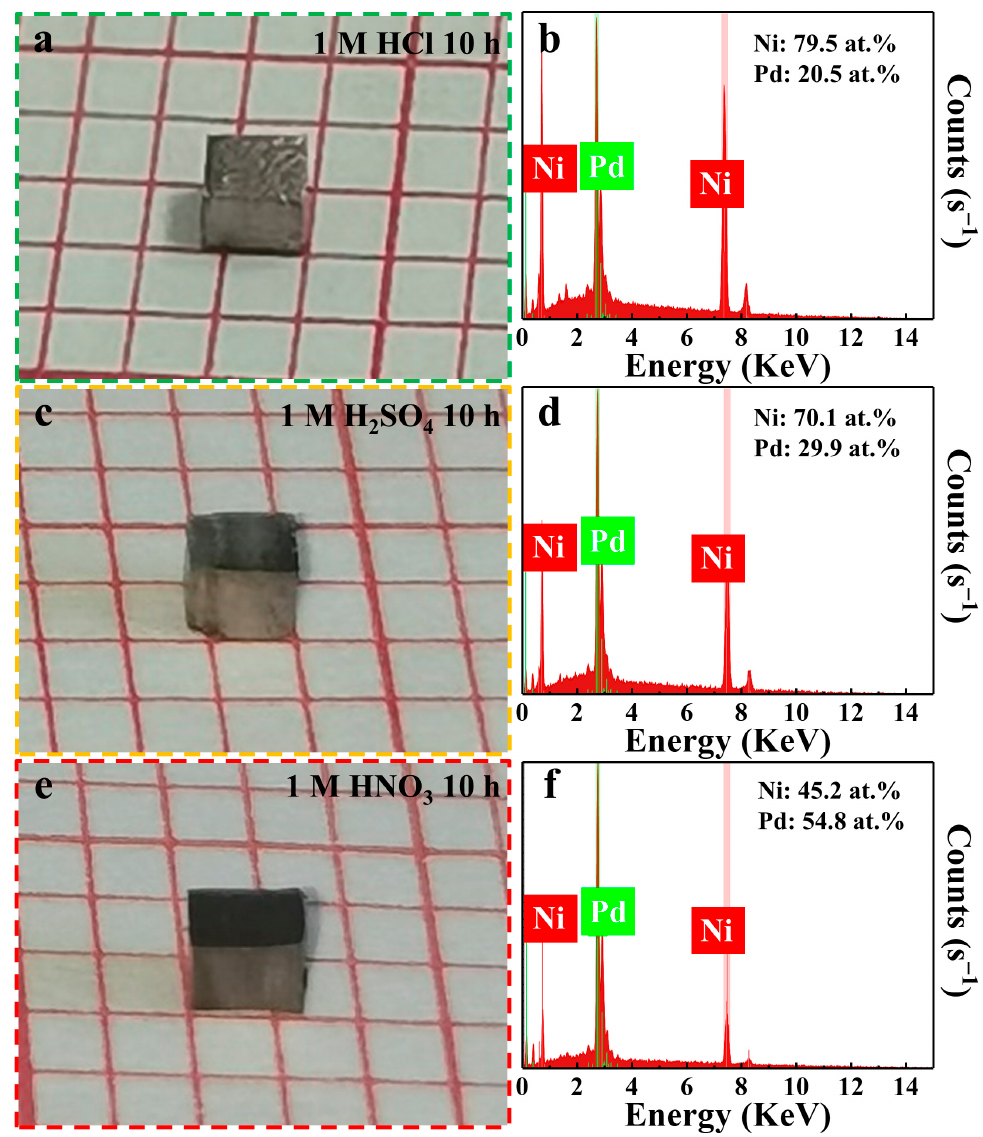
Figure 4. ( a , c , e ) The photos of the as-annealed Ni 80 Pd 20 alloy after different acid leaching treatments, and ( b , d , f ) typical EDS spectra of the external surface of the corresponding samples. The average chemical compositions are shown in the EDS spectrum as an inset.